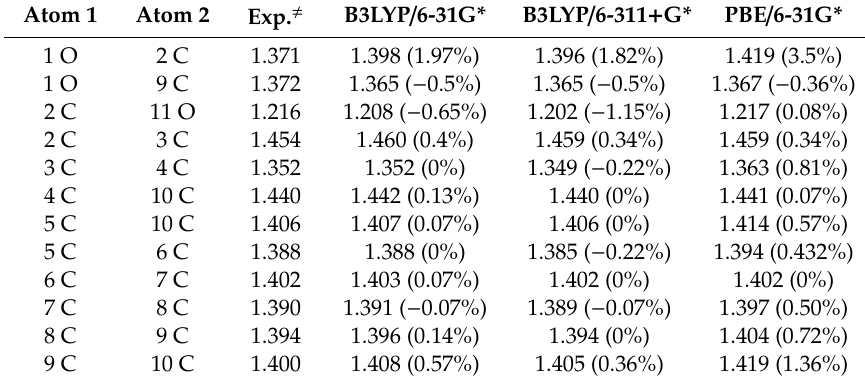
Table 1. Comparison of optimized bond length distances for coumarin with corresponding experimental data. Variation in the bond lengths is reported in %. The numbering scheme of coumarin molecule is same as shown in Figure 3. The bond lengths are reported in angstrom (Å), and up to four significant figures.